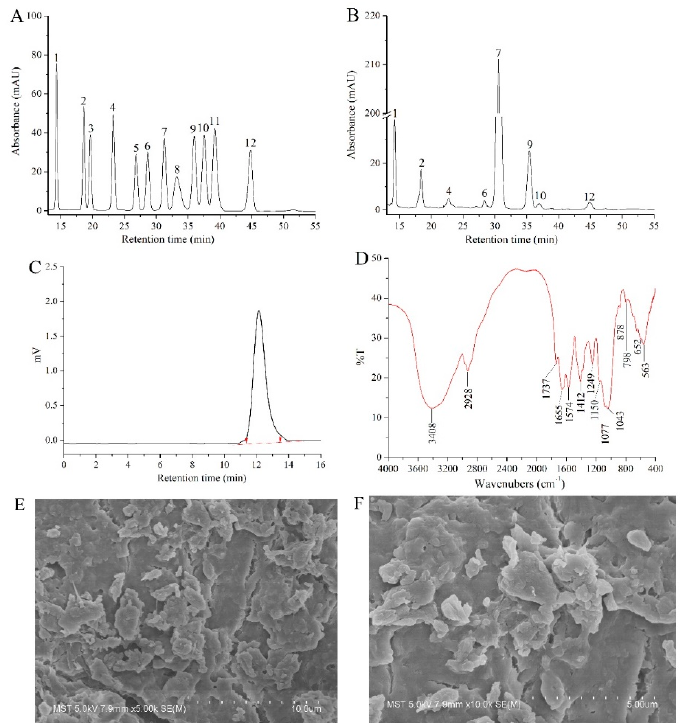
Figure 2. Physicochemical analysis of AcPPS. High-performance gel permeation chromatography (HPGPC) of ( A ) standard sugars and ( B ) AcPPS; ( C ) molecular weights by gel permeation chromatography (GPC); ( D ) Fourier transform infrared spectroscopy (FT-IR) spectra analysis; ( E ) scanning electron microscopy (SEM) images of AcPPS (5000 × ); ( F ) SEM images of AcPPS (10,000 × ). Peaks: (1) mannose (Man), (2) ribose (Rib), (3) rhamnose (Rha), (4) glucuronic acid (GlcA), (5) galacturonic acid (GalA), (6) glucosamine (GlcN), (7) glucose (Glc), (8) aminogalactose (GalN), (9) galactose (Gal), (10) xylose (Xyl), (11) arabinose (Ara), and (12) fucose (Fuc).